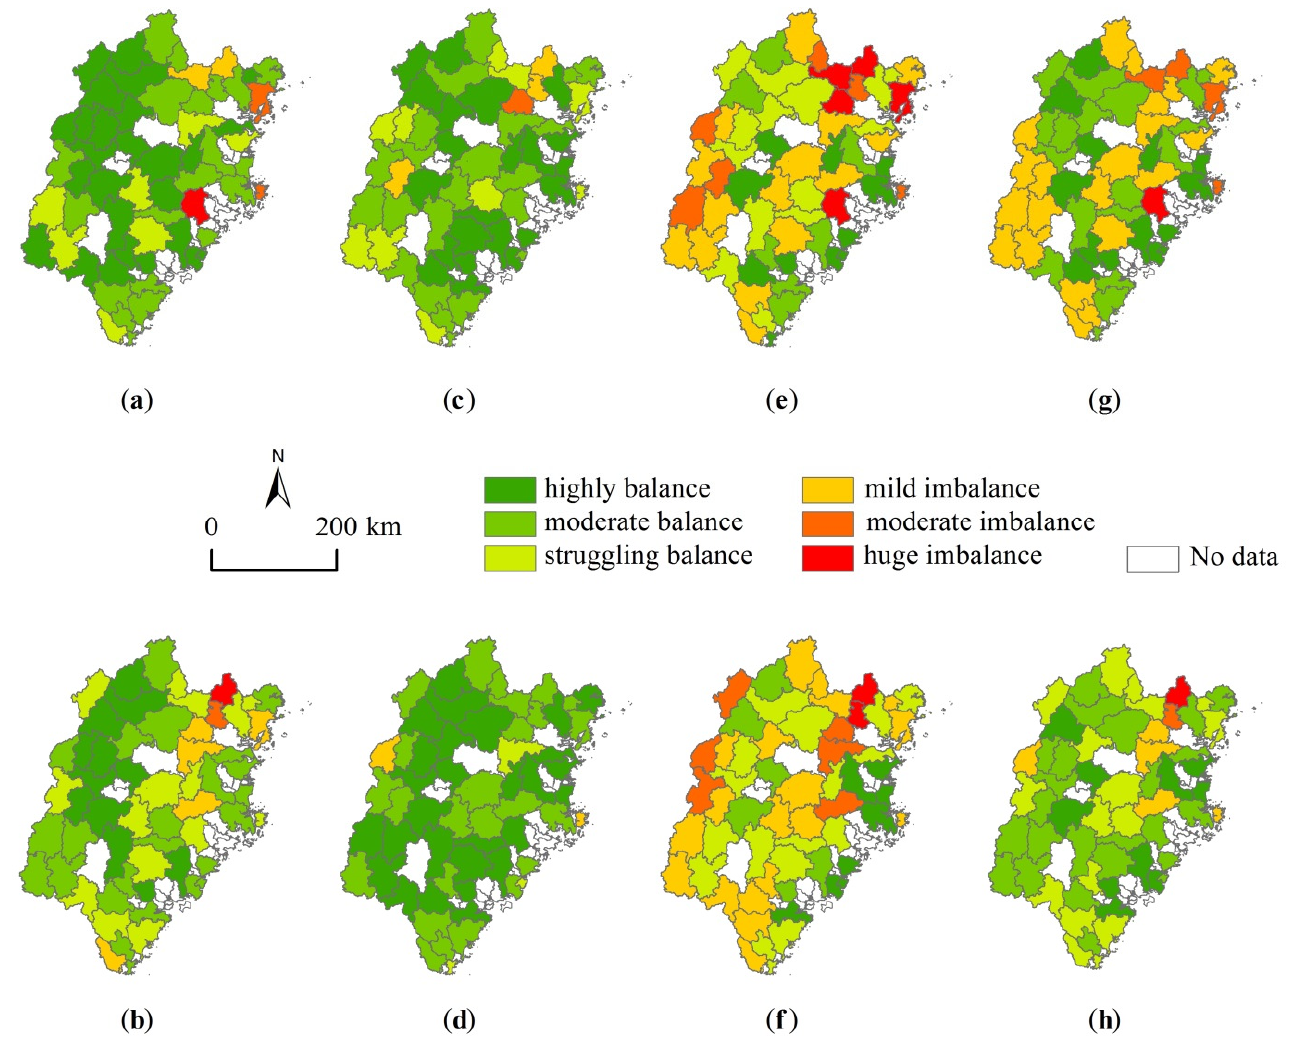
Figure 3. Coordination type of the 58 counties in Fujian province in 2000 and 2018. ( a ) Coordination type of EI & EC in 2000; ( b ) Coordination type of EI & EC in 2018; ( c ) Coordination type of EI & TR in 2000; ( d ) Coordination type of EI & TR in 2018; ( e ) Coordination type of EC & TR in 2000; ( f ) Coordination type of EC& TR in 2018; ( g ) Coordination type of EI & EC & TR in 2000; ( h ) Coordination type of EI & EC & TR in 2018.